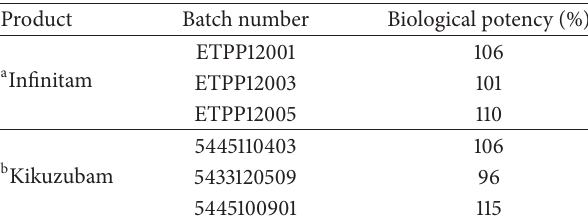
Table 6: Biological potency for Etanercept and Rituximab